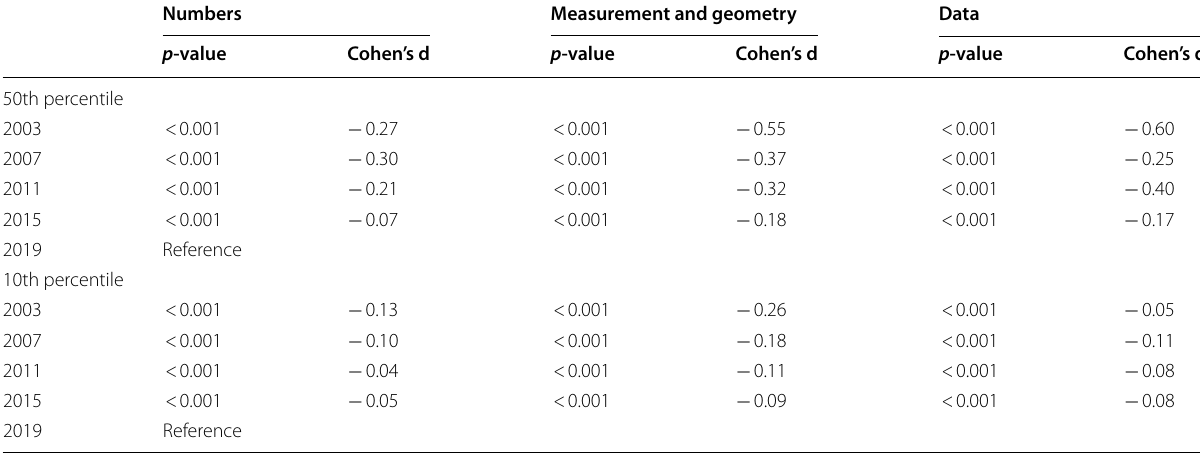
Comparisons are made to 2019 as reference. Negative d represents lower performance compared to the 2019 cycle